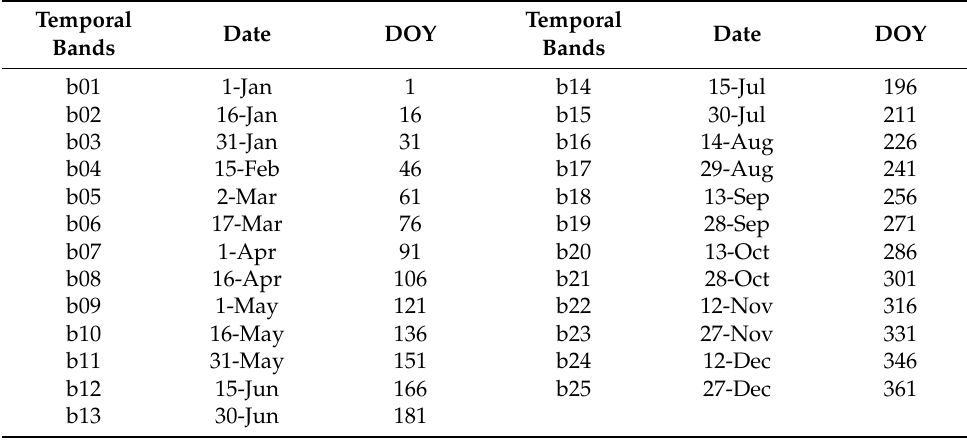
Table 3. Correspondence between NDVI temporal bands and date.